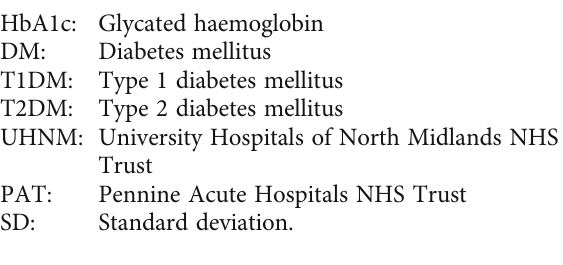
Supplemental Figure S1: approach used to identify the patient cohort. (Supplementary